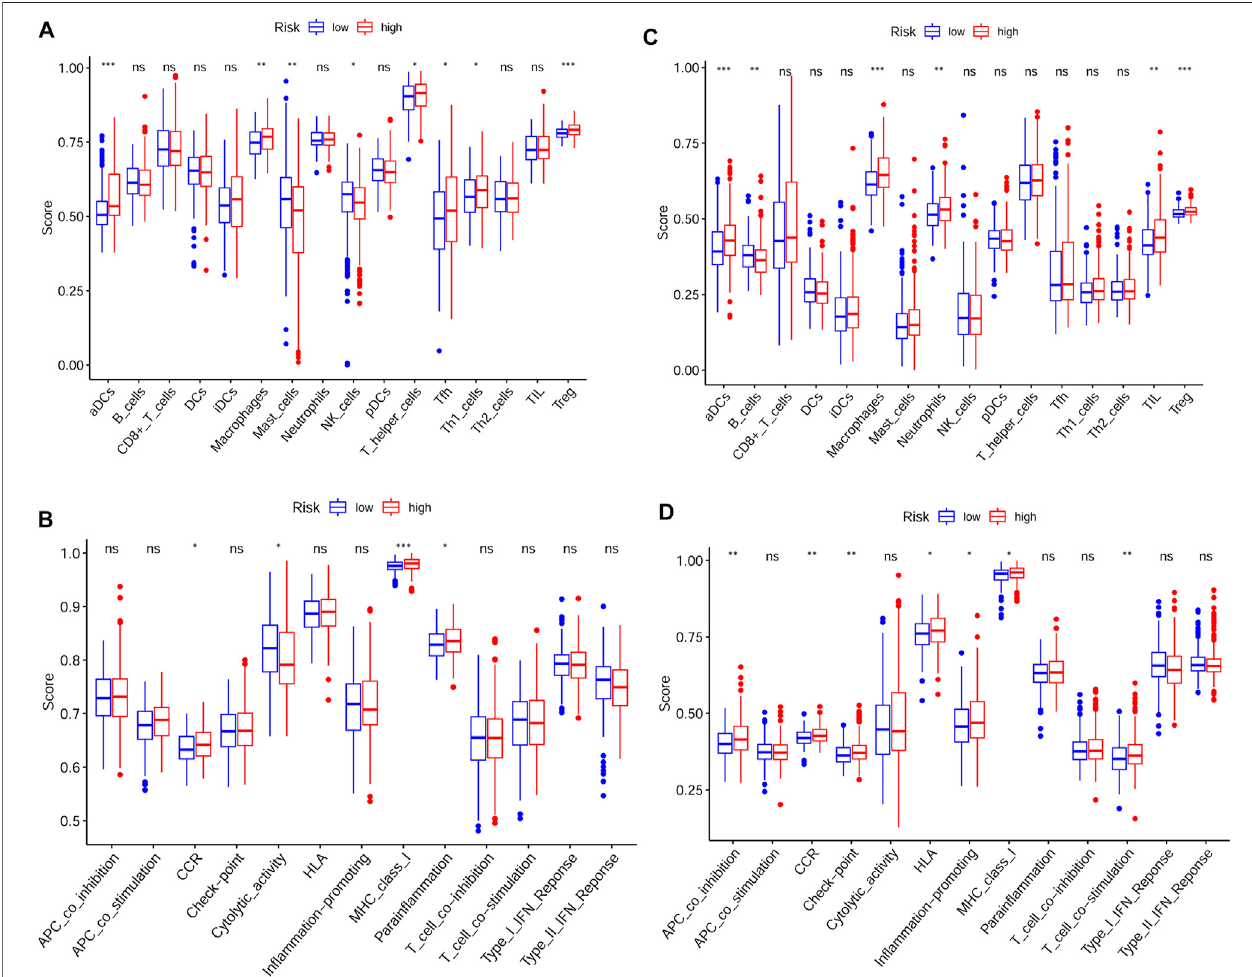
FIGURE 7 | Immune status between the high-risk and low-risk groups analyzed by ssGSEA (A,B) Immune cells and immune-related pathways between the high- risk and low-risk groups in the TCGA cohort (C,D) Immune cells and immune-related pathways between the high-risk and low-risk groups in the GEO cohort ( p values were represented as: ns not signi fi cant; * p < 0.05; ** p < 0.01; *** p <